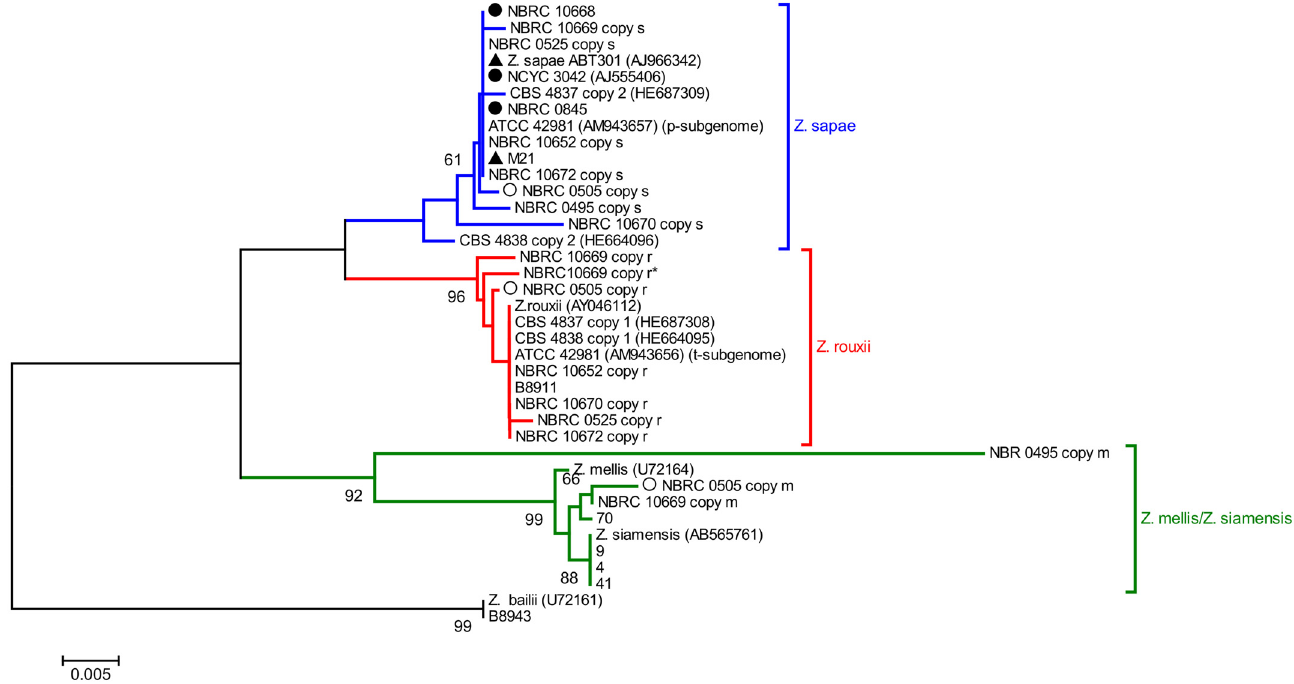
Fig 4. Phylogenetic relationships within the Z . rouxii complex based on 26S rDNA D1/D2 sequences. This phylogeny was inferred using the Neighbor-Joining method using D1/D2 sequence of Z . bailii CBS 680 T (GenBank accession number U72161) as outgroup. The percentages of replicate trees in which the associated taxa clustered together in the bootstrap test (10,000 replicates) are shown next to the branches (only values higher than 60% are reported). The tree is drawn to scale, with branch lengths in the same units as those of the evolutionary distances used to infer the phylogenetic tree. The evolutionary distances were computed using the Tajima-Nei method [48]. All positions containing gaps and missing data were eliminated. Z . rouxii , Z . sapae , and Z . mellis clades are colored in red, blue, and green, respectively. Black triangles represent strains with homogeneous 26S rDNA D1/D2 domains and heterogeneous ITS regions. Black circles indicate strains without rDNA heterogeneity. White triangles indicate strains with heterogeneous 26S rDNA D1/D2 domains and homogeneous ITS rDNA